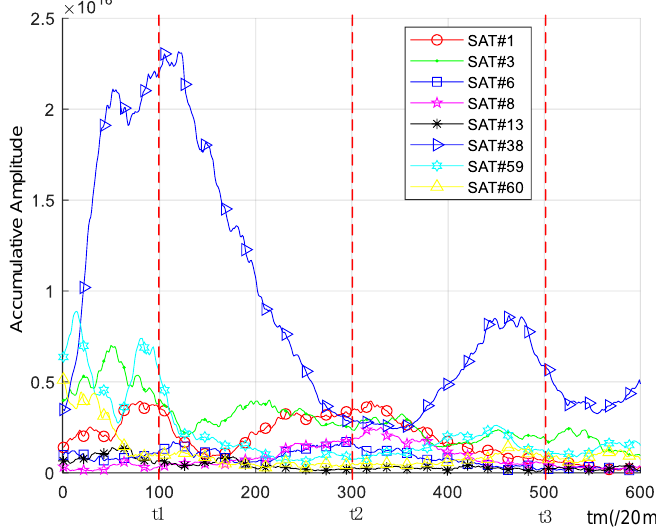
Figure 18. Signal energy distribution and comparison of 8 satellites.